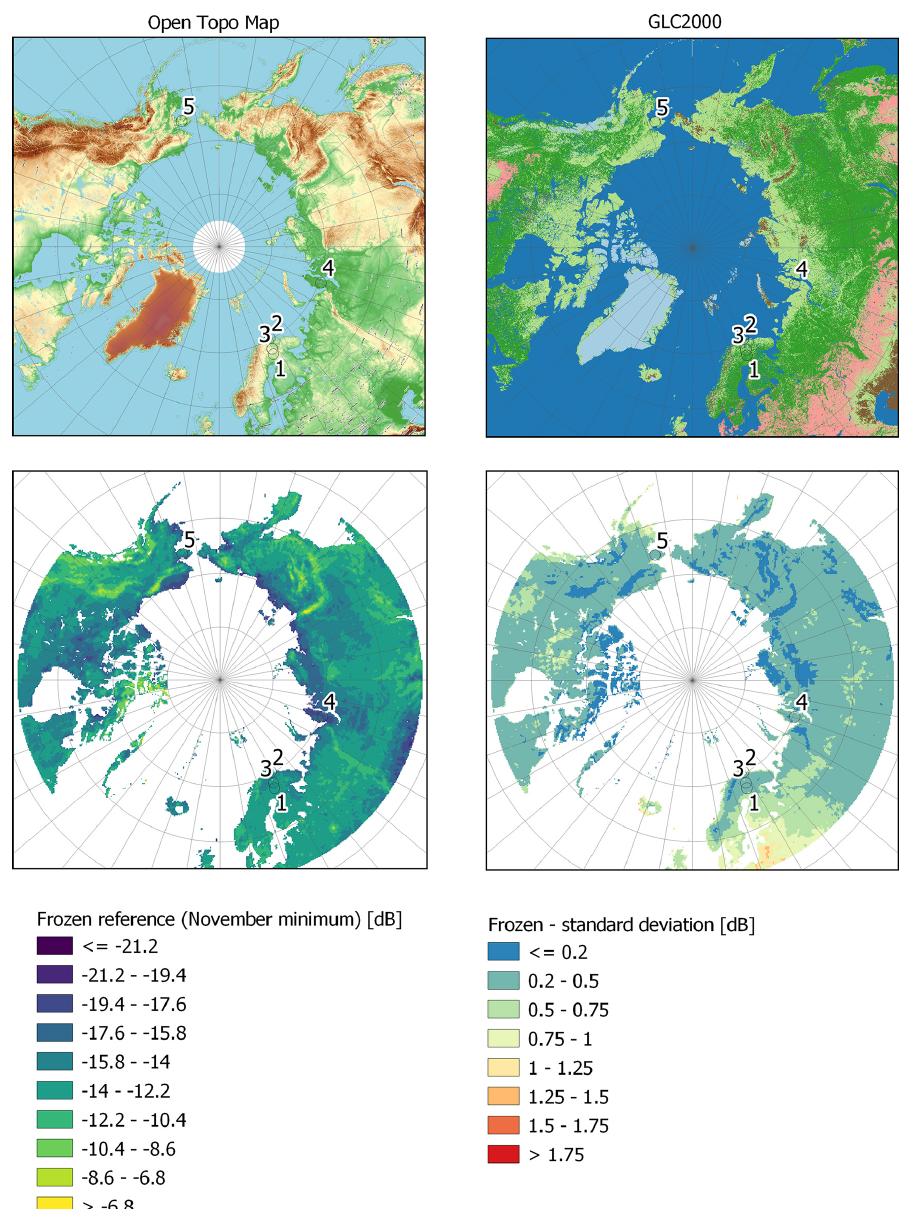
Figure 2. Characteristics of ASCAT analysis extent. Upper left: digital terrain model (source: © OpenStreetMap Contributors, SRTM; MapView: © OpenTopoMap (CC-BY-SA)); upper right: land cover (source: Global Land Cover 2000 database; European Commission, Joint Research Centre, 2003; dark green – forest; bright green – shrubs to sparse vegetation; brown – bare; grey – burned forest; coral – culti- vated; red – artificial). Metop ASCAT characteristics considered for ROS retrieval: frozen soil reference (lower left) and standard deviation for November to February (lower right) for σ 0 . Circles: in situ and ROS case study sites: 1 – Sodankylä; 2 – Varanger Peninsula/upper Komagdalen; 3 – Saariselkä/Niilanpää; 4 – Yamal Peninsula; 5 – Seward